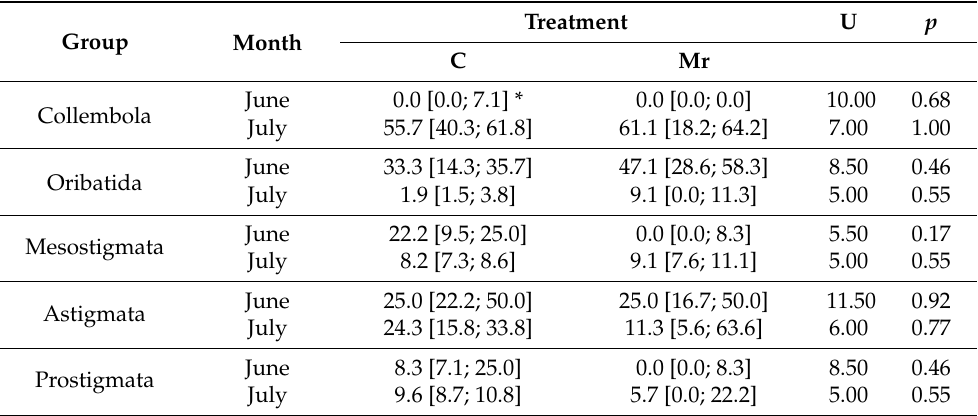
Table 7. Results of comparative analysis of the proportion of individual groups of soil microarthro- pods in the communities in the plots taking into account positive plant colonization by the fungus in 2020 (Mann–Whitney